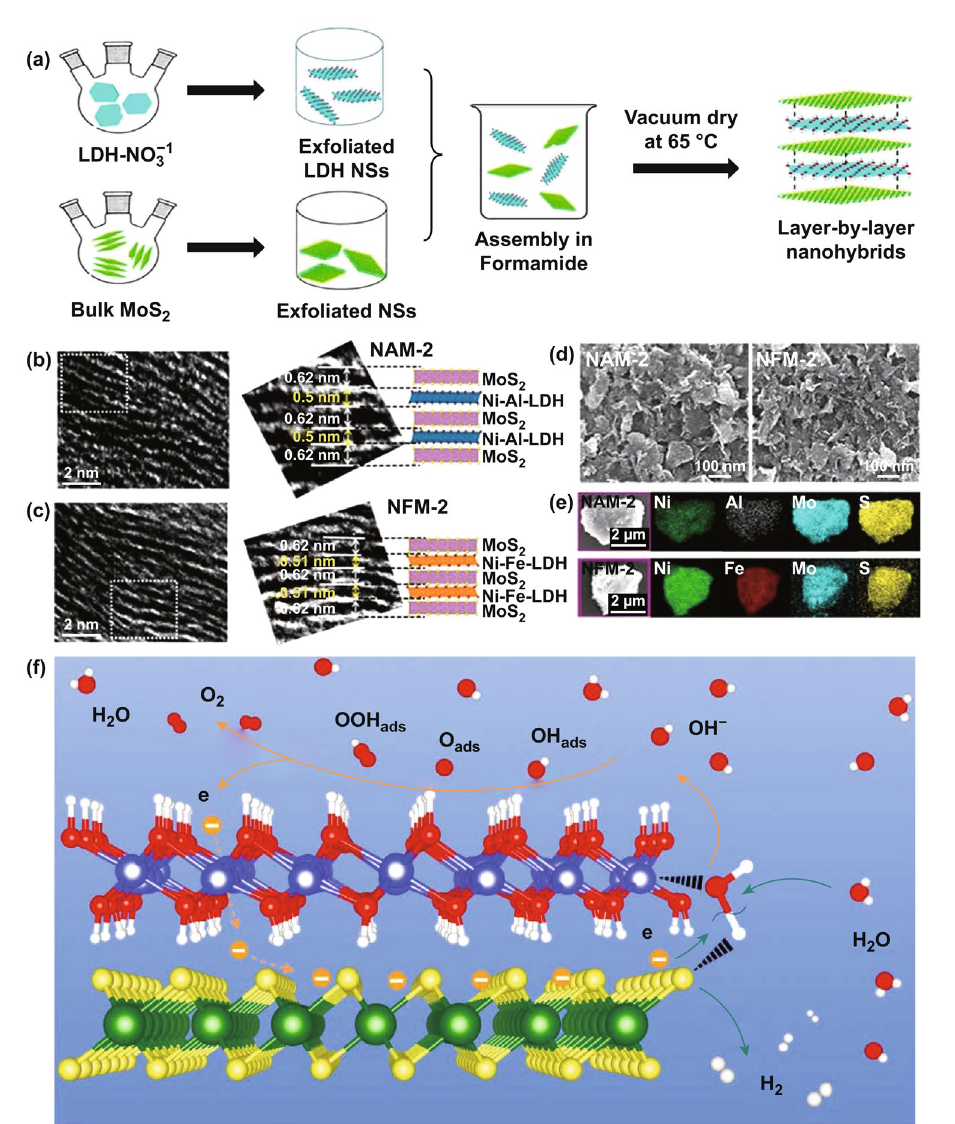
Fig. 12 a Synthesis process, b, c cross‑sectional TEM images, d FE‑SEM images, and e EDS elemental mappings of NiAl LDH/MoS 2 and NiFe LDH/MoS 2 . Reproduced with permission from Ref. [128]. Copyright 2018 American Chemical Society. f Schematic illustration of the electrocatalytic mechanism of water splitting on the interface of MoS 2 /LDH superlattice. Reproduced with permission from Ref. [129]. Copy‑ right 2019 American Chemical